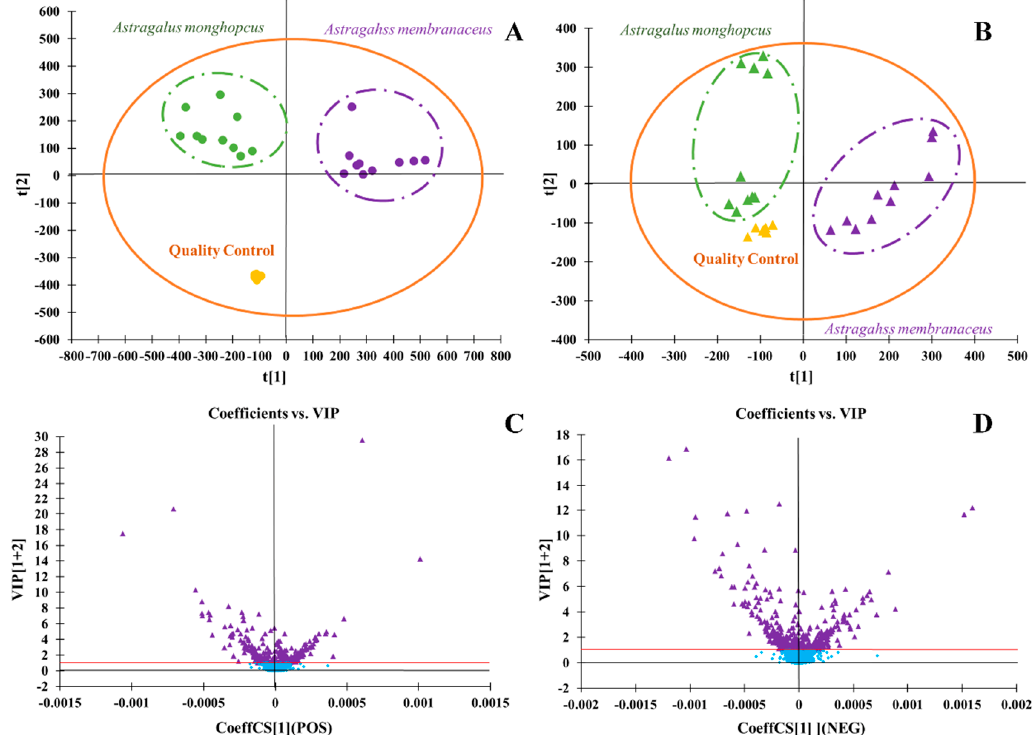
Figure 3. The analysis of MG and MJ samples by UHPLC-ESI-Q-TOF-MS / MS. ( A )-The principal component analysis (PCA) scores plots in positive ion mode; ( B )-the PCA scores plots in negative ion mode; ( C )-the variable importance in the projection (VIP) plot of the ions whose value ≥ 1 in positive ion mode; ( D )-the VIP plot of the ions whose value ≥ 1 in negative ion mode.